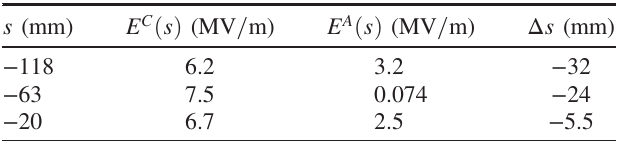
TABLE IV. Absolute values of E C ð s Þ and E A ð s Þ and deviation TABLE V. Absolute values of E C ð s Þ and E A ð s Þ and